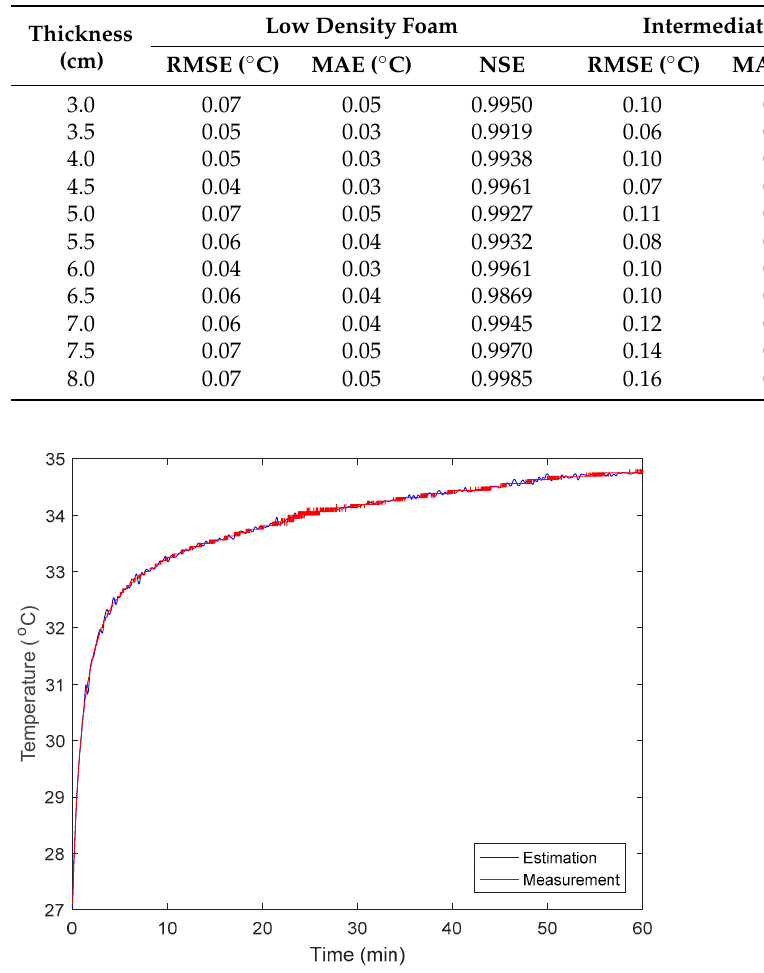
Figure 7. Comparison between DCTM (the red curve referred to as “Measurement” in the graph) and ANN-based estimation (the blue curve referred to as “Estimation” for clarity in the graph) using a randomly selected one-hour NCTM dataset (low density foam with thickness = 5 cm).